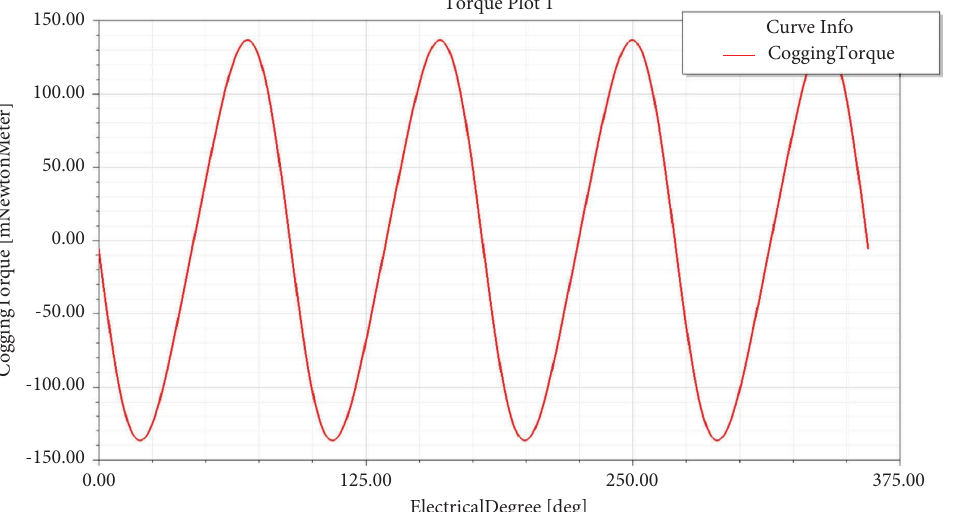
Figure 5: Torque curve of 4-pole 30-slot